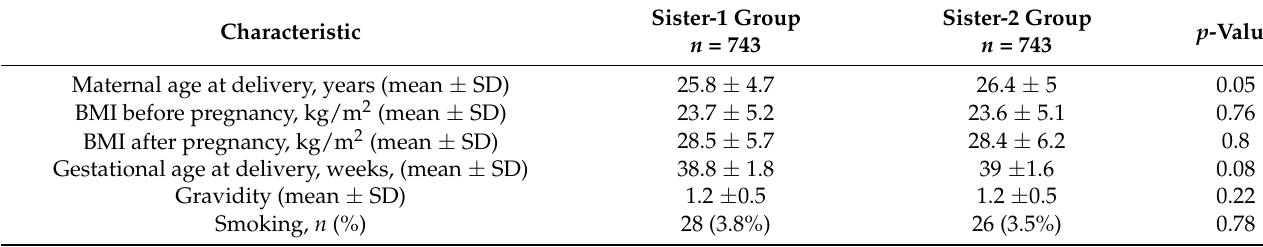
Table 1. Baseline characteristics of sisters.